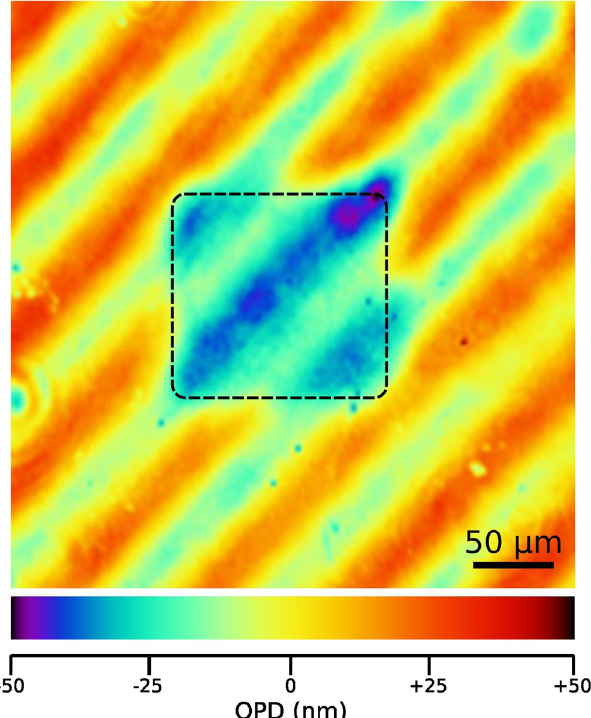
Figure 3. OPD micrograph. OPD map obtained by laser interferometric microscopy from a 125 × 125 μ m 2 region irradiated with 5 MeV H + at a fluence of 8.7 × 10 16 cm − 2 . The colour scale at the bottom encodes the measured OPD variation for each pixel. The irradiated region is highlighted by the dashed-line square and is characterized by a different optical thickness with respect to the surrounding region. Interference fringes due to multiple internal reflections are also clearly distinguishable in both the irradiated and non-irradiated